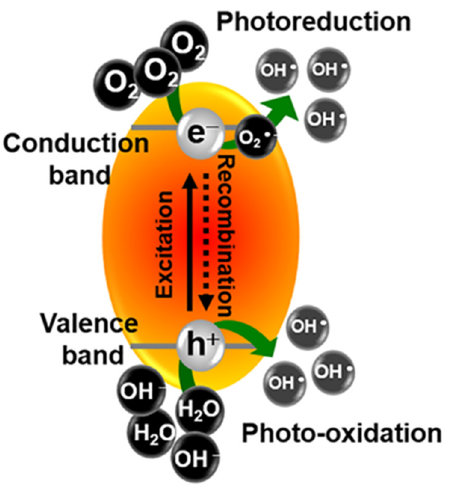
Figure 1. Schematic illustration of the photo-generation of charge carriers in a